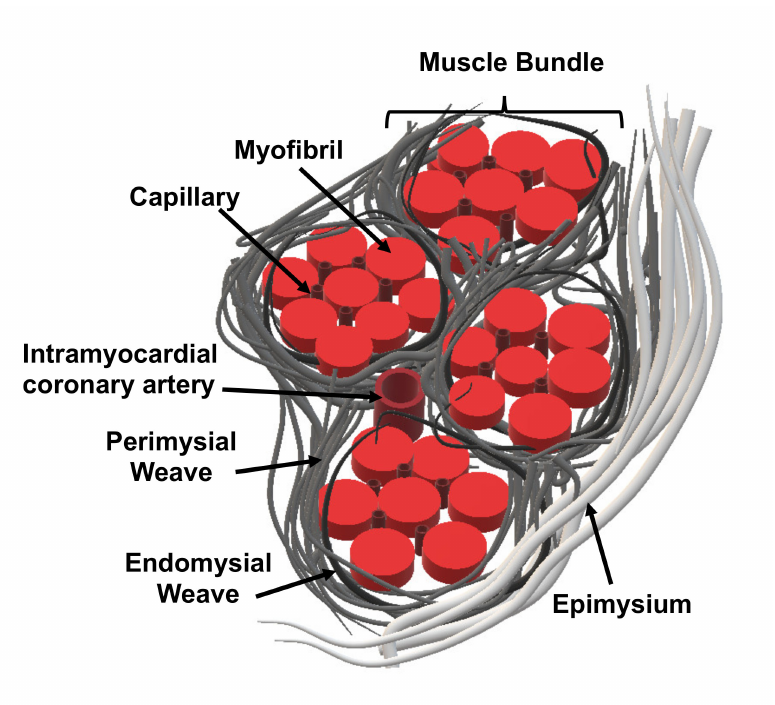
Figure 7. Schematic of cardiac extracellular